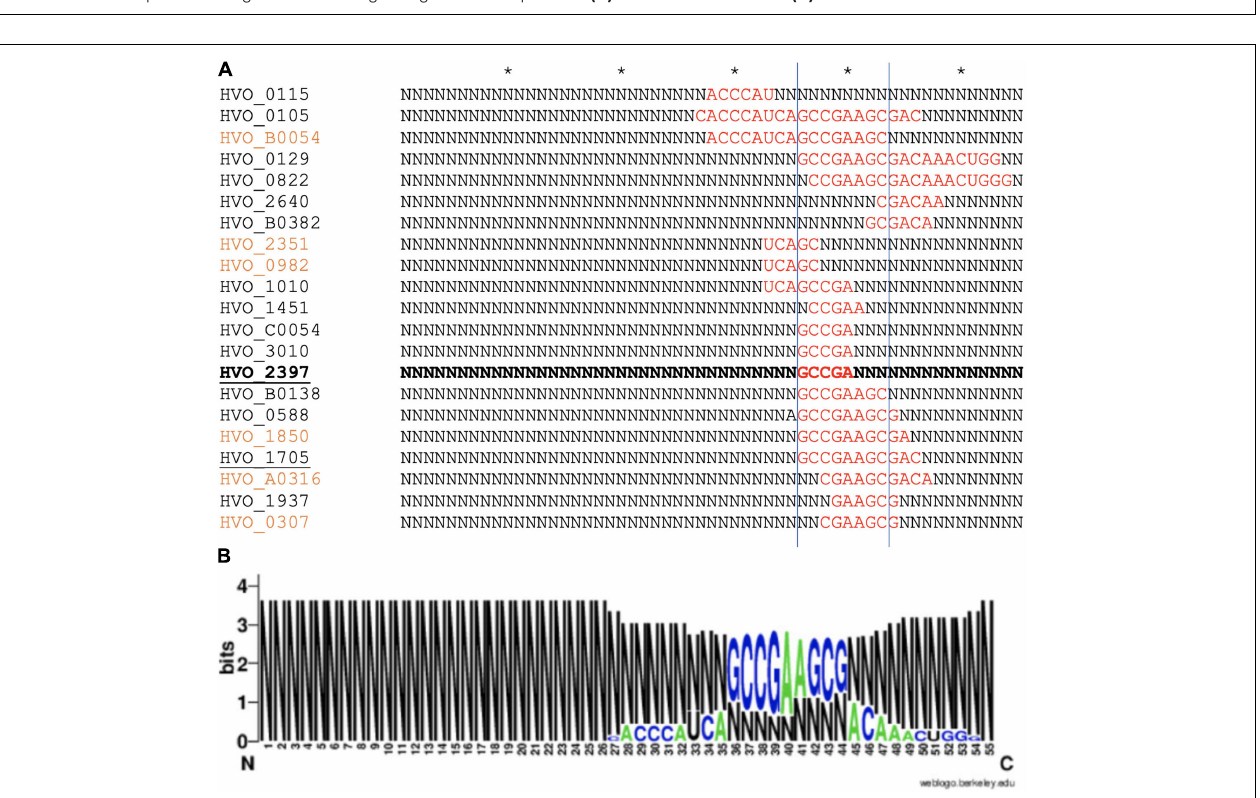
FIGURE 8 | Interacting sequences of the znu C1 transcript and s479. (A) The two potential interaction sites for the znu C1 transcript are indicated by red boxes. The coding region is shown in black and numbering starts with the A of the start codon ATG. (B) The mature s479 is shown, and numbering is according to the full primary transcript as shown in Figure 3 , where the mature s479 starts at +49. The part of s479 interacting with the znu C1 mRNA is shown in the red box, situated at the 3 (cid:48) end. The predicted target–sRNA binding configuration is depicted in (C) for interaction 1 and in (D) for interaction 2.